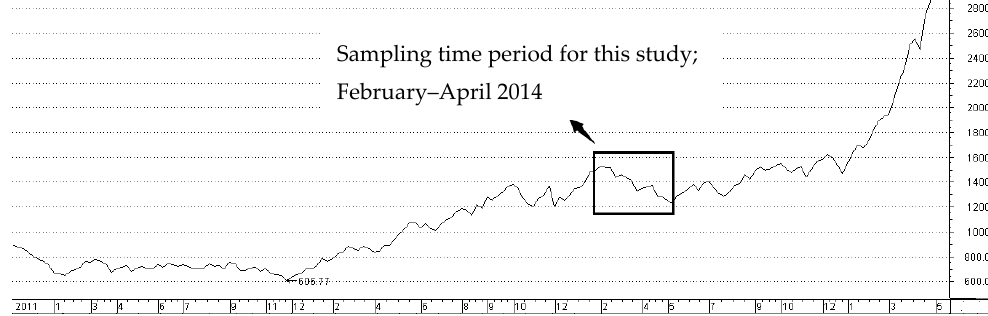
Figure 1. Sampling period in the High Tech Listed Company Market (known as the Second Board Stock Market) in China. The chart shows fluctuations and a developing curve of the Growth Enterprise Index (GEI, which is formed by opening quotation and provided by Shenzhen Fortune Trend Technologies Inc.; the software can be downloaded at http://www.tdx.com.cn) in the Second Board Stock Market in China from November 2011 to April 2015. This chart shows the changes in the developments for each day, contrasted with the respective transaction time period at the bottom. In the above chart the sampling periods (March 2014 and May 2014) of this study are